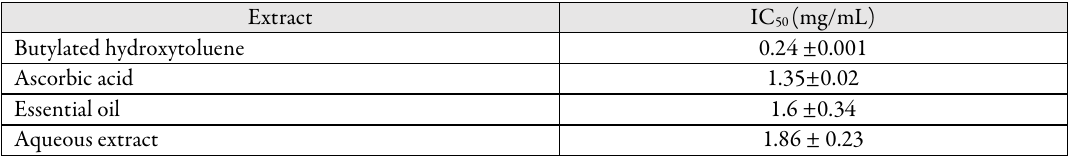
Table 7. Antioxidant activities (expressed as IC 50 in mg/mL) of the reference antioxidant and tested extracts of L. angustifolia